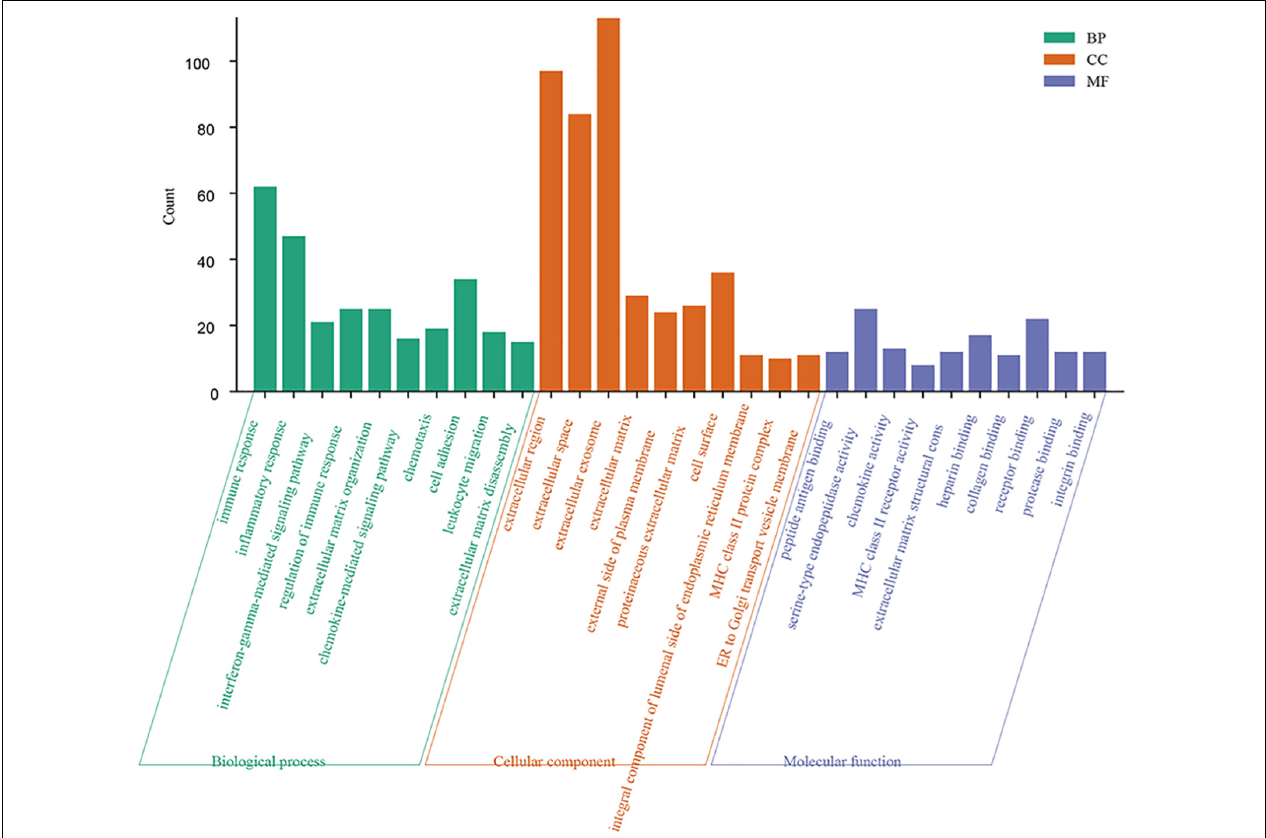
FIGURE 3 | Function enrichment analysis of 342 intersection genes. Top 10 enriched GO terms of 342 common DEGs. Significantly GO terms were identified using DAVID functional annotation tool (https://david.ncifcrf.gov/). FDR smaller than 0.05 was used as the criteria for significantly enriched. Enriched GO terms included three categories: biological process, cellular component, and molecular function.